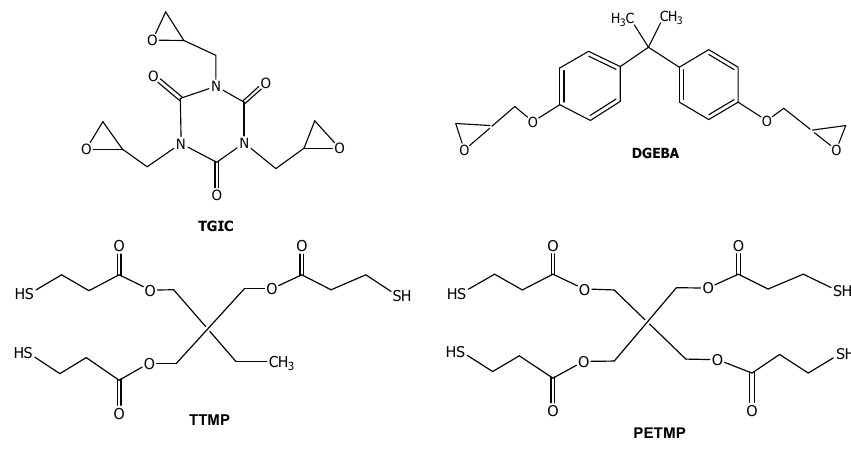
Scheme 1. Chemical structures of the compounds